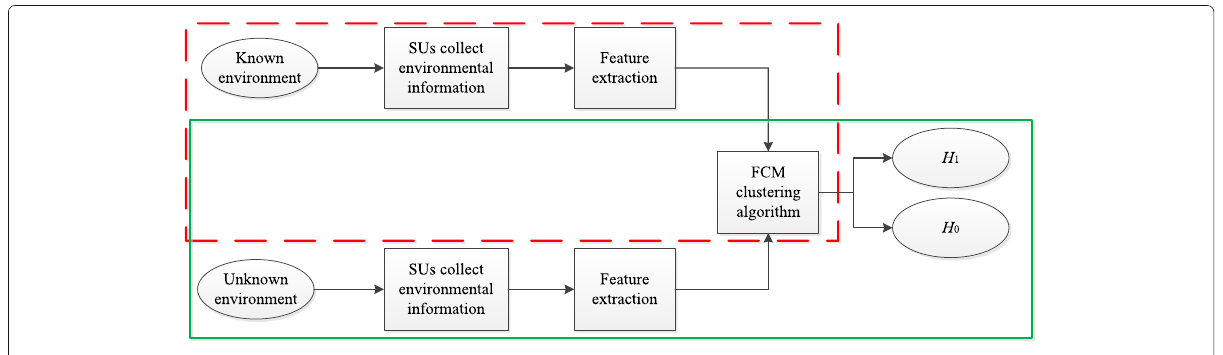
Fig. 3 The overall flow of the IGFCM method